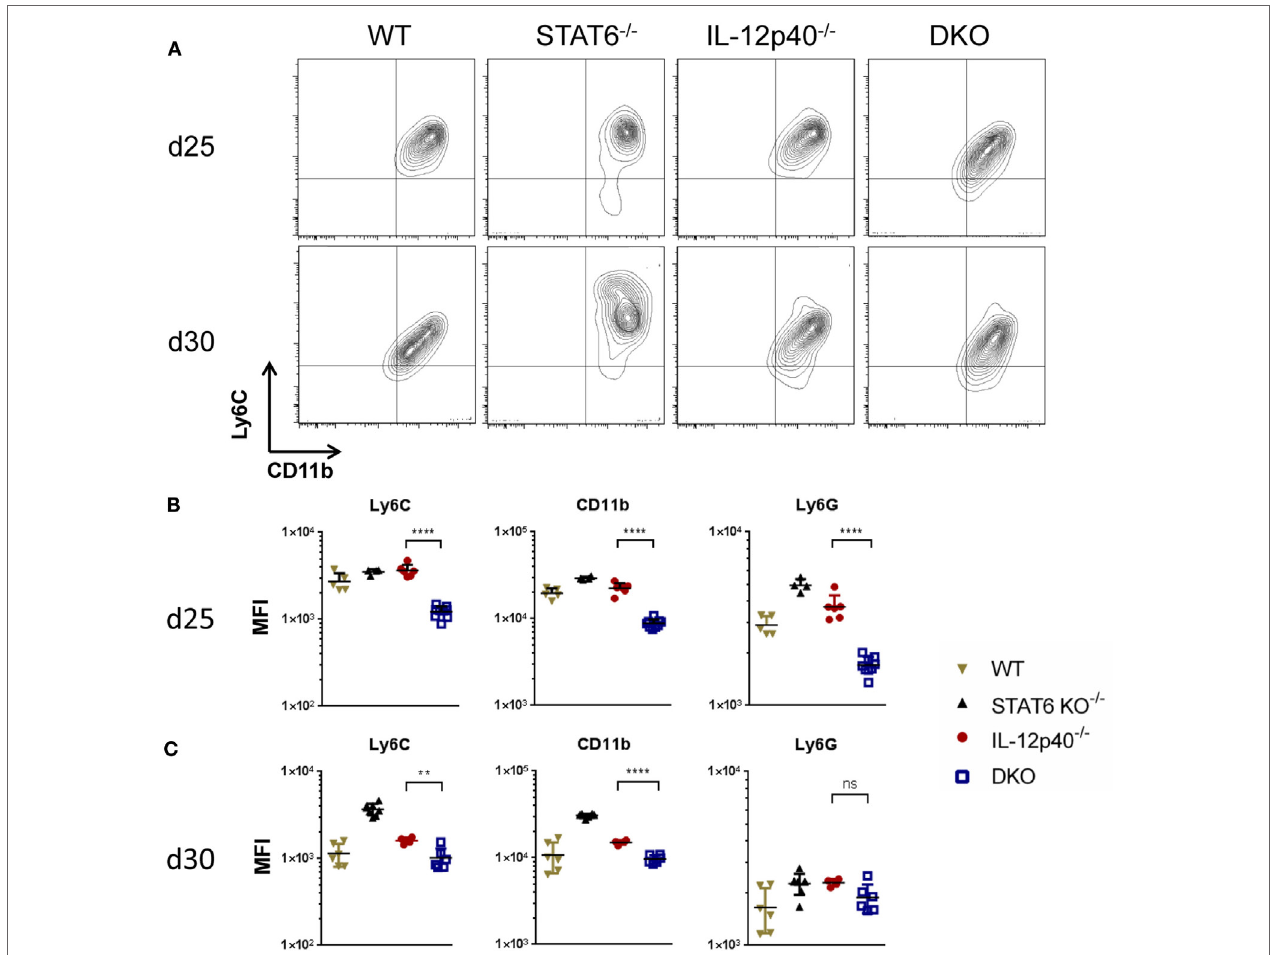
FigUre 4 | Neutrophils in IL-12p40 − / − STAT6 − / − double knockout (DKO) mice express lower levels of Ly6C, CD11b, and Ly6G. Wild type, IL-12p40 − / − , STAT6 − / − , and DKO BALB/c mice were infected with 2 × 10 6 metacyclic promastigotes. Footpads of naïve and infected mice at d25 post-infection ( p.i. ) (a,c) and d30 p.i. (B,c) were homogenized and analyzed by flow cytometry as explained in Figure S2 in Supplementary Material. Ly6G + neutrophils were plotted on Ly6C versus CD11b axes (a,B) and their MFI for Ly6C, CD11b, and Ly6G calculated (B,c) . Data represent three independent experiments with at least four footpads per group. Error bars are shown as SD. ** p < 0.01, **** p <